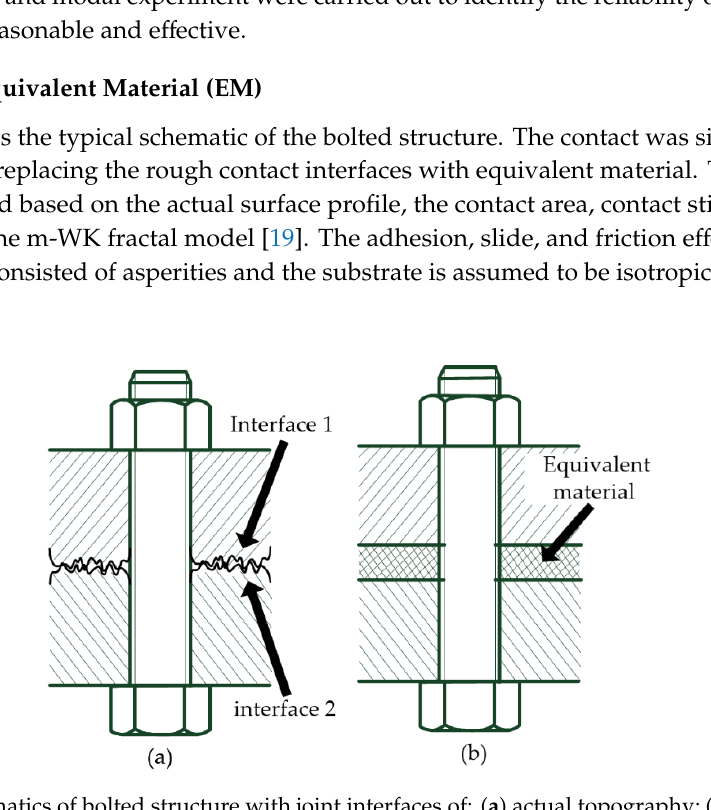
Figure 1. Schematics of bolted structure with joint interfaces of: ( a ) actual topography; ( b ) equivalent material (EM).